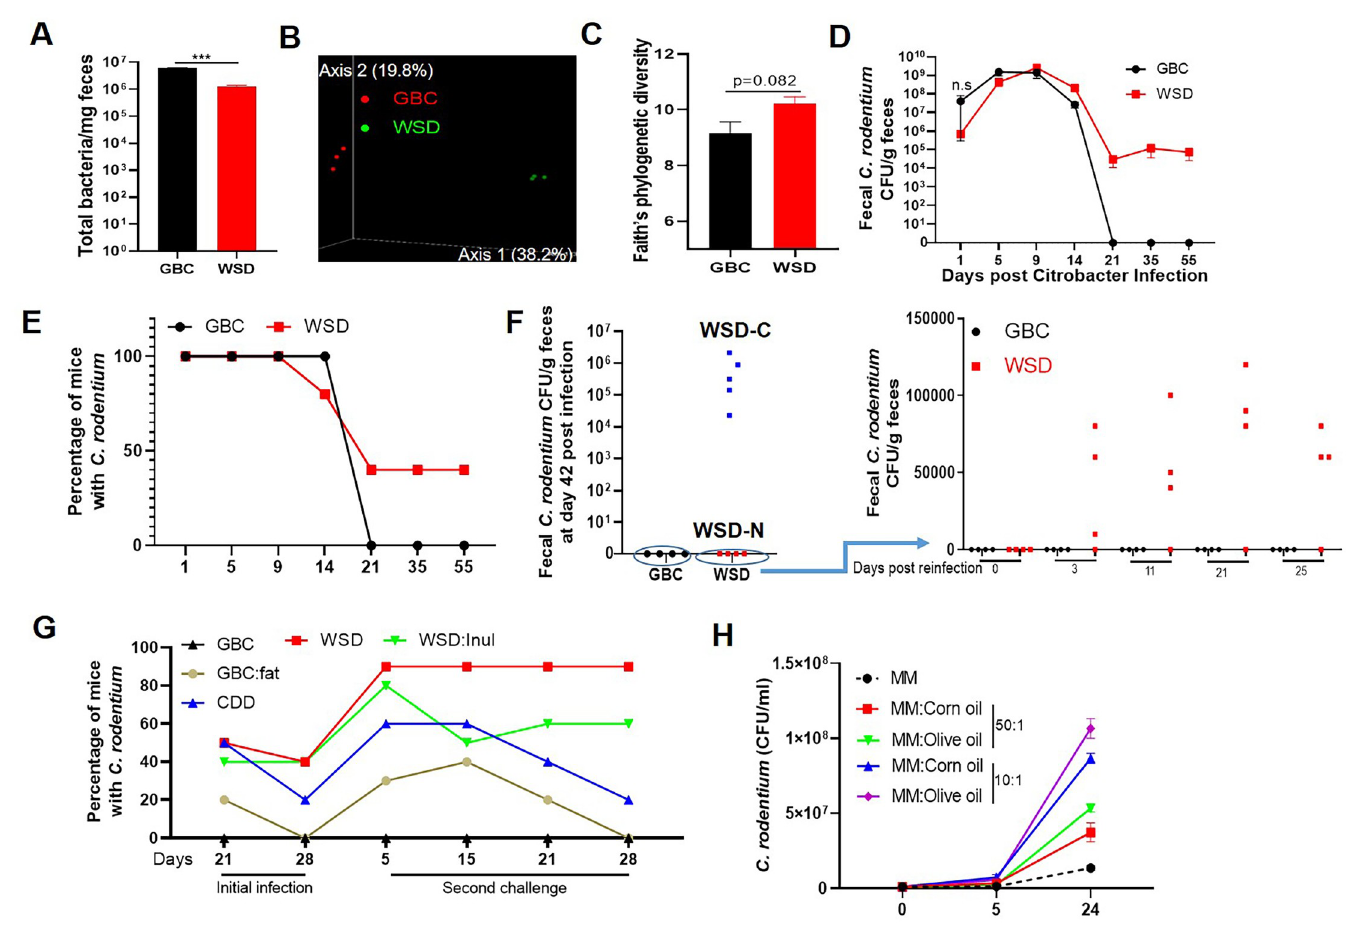
Fig 1. WSD-induced alterations in gut microbiota associate with inability to clear C . rodentium . A-C. Adult C57BL/6 mice were maintained on GBC or administered WSD for 1 week. A. Bacteria per mg feces were measured by qPCR. B. Gut microbiota composition was analyzed by 16s rRNA sequencing followed by UniFrac PCoA analysis. C. Faith’s phylogenetic diversity. D-E. Fecal C . rodentium CFU following its oral inoculation. Mean fecal CFU per mouse ( D ) and percentage of mice with detectable C . rodentium ( E ). F. Mice that had no detectable C . rodentium (GBC or WSD-N) were re-inoculated with C . rodentium , and fecal C . rodentium CFU quantitated. G . Ability of mice fed indicated diets to clear primary and secondary C . rodentium challenge was assayed as in E-F. H . Growth curves of C . rodentium in minimal media supplemented with different types/amount of lipid. Data are the means +/- SEM (n = 3–10 mice per group) of an individual experiment and representative of 2–3 separate